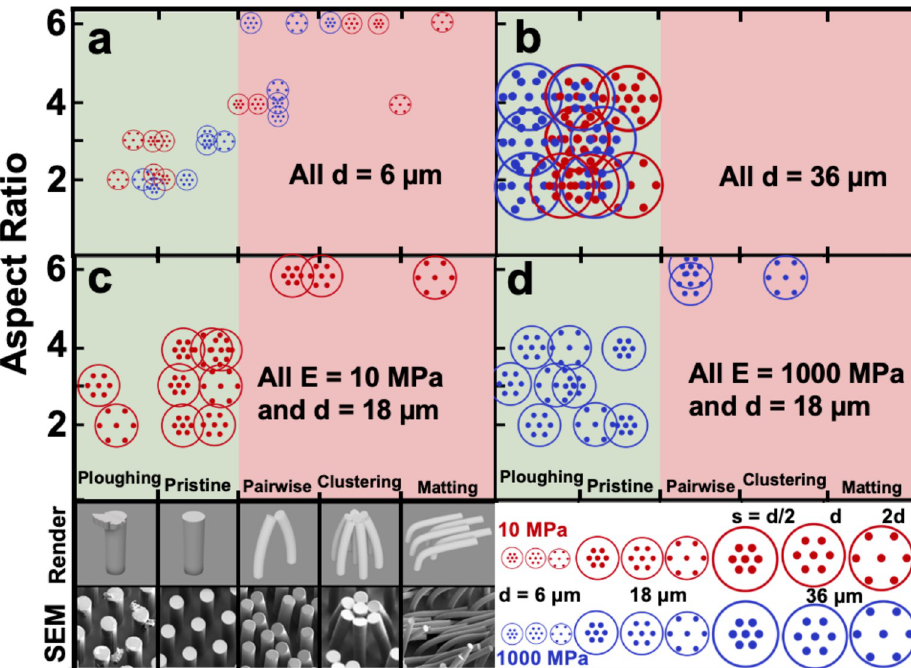
Fig 3. Survivability of tested micropillar arrays. Panel (a) displays the smallest diameter micropillars (d = 6 μ m) that were the most prone to deformation and the only diameter to display lateral and ground collapse phenomena at both 4:1 and 6:1 aspect ratios. In contrast, panel (b) shows the outcome for micropillar arrays with the largest diameter (d = 36 μ m) for both materials. The medium diameter (d = 18 μ m) micropillars for the more compliant material (E = 10 MPa) are shown in (c) while the medium diameter micropillars composed of the stiffer polymer (E = 10 MPa) are shown in subpanel